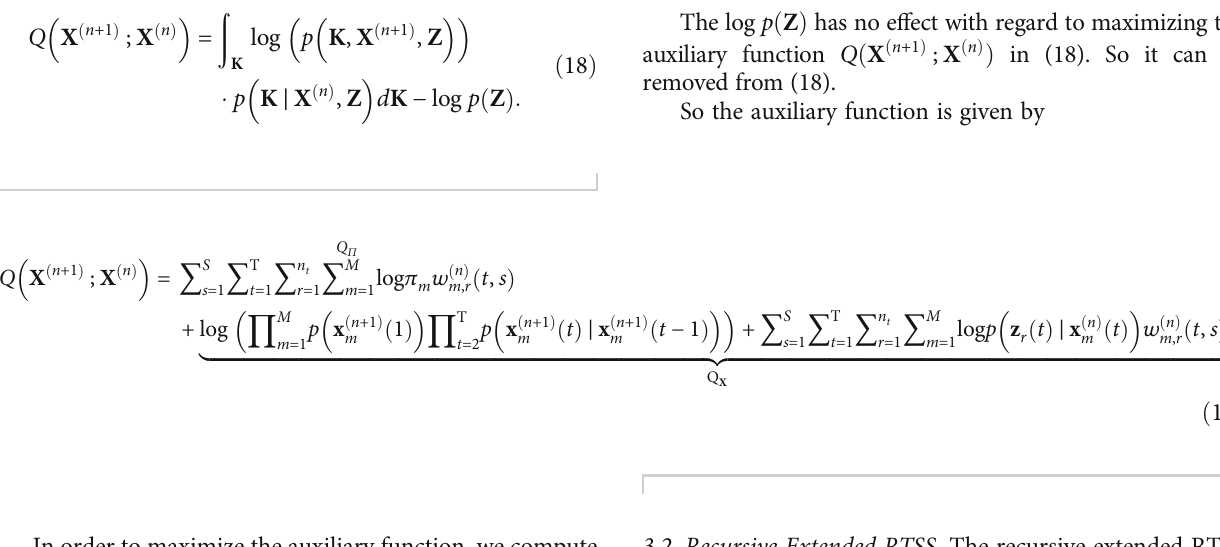
Figure 3: The tracking scenario of multiple targets, given two passive static sensors, true target trajectories, and estimated